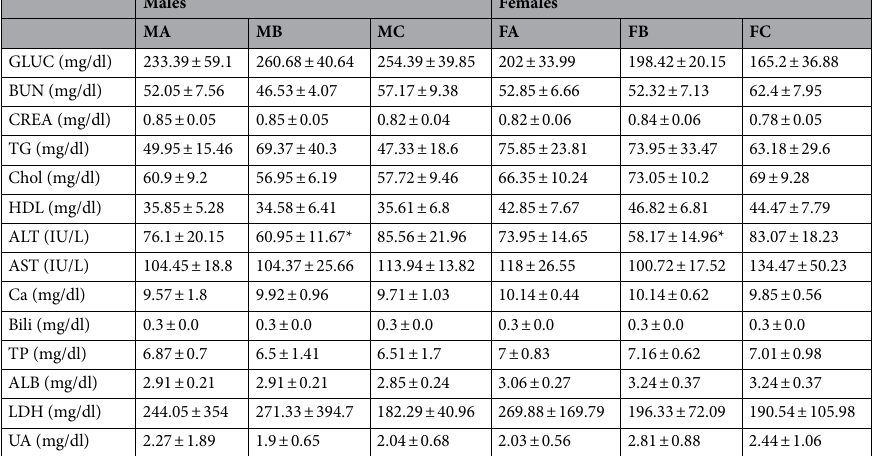
Table 3. Hematological parameters in the studied groups on the 90th day. Each value is presented as mean ± SD. MA: male rats with Tarom molaii rice feeding, MB: male rats with GM Bt rice feeding, MC: male rats with standard feeding, FA: female rats with Tarom molaii rice feeding, FB: female rats with GM Bt rice feeding, FC: female rats with standard feeding. WBC: white blood cell, RBC, red blood cell; HGB, hemoglobin; HCT, hematocrit; PLT, platelet; MCV, mean cell volume; MCH, mean cell hemoglobin; MCHC, mean cell hemoglobin concentration; RDW, red blood cell distribution width; PDW, platelet distribution width; MPV, mean platelet volume; PCT,